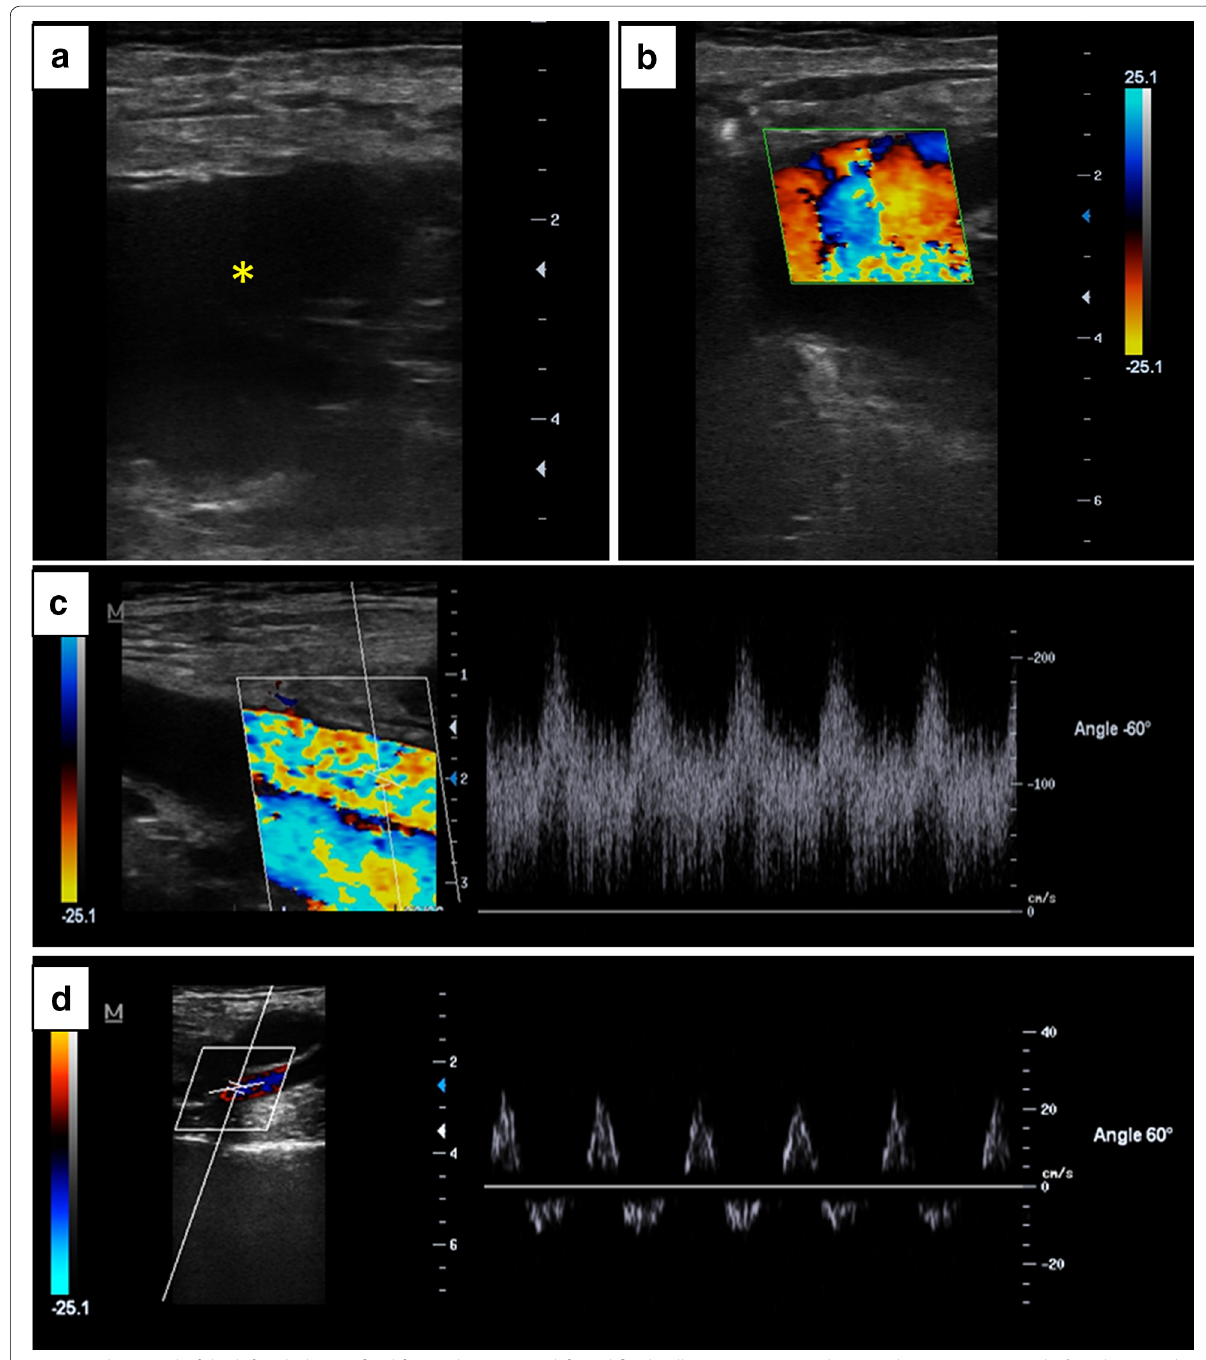
Fig. 1 Stab wound of the left-sided superficial femoral artery. a Subfascial fluid collection corresponding to a hematoma (asterisk); b Color Doppler demonstrating flow in the hematoma, corresponding to a pseudoaneurysm; c spectral Doppler of the superficial femoral artery proximal to the site of injury, showing high-velocity monophasic waveforms, indicating a reduction in the vascular resistance distal to the insonation site (arterial laceration) and compensatory flow; d spectral Doppler in arteries distal to the site of injury, showing low-velocity biphasic waveforms, indicating low blood